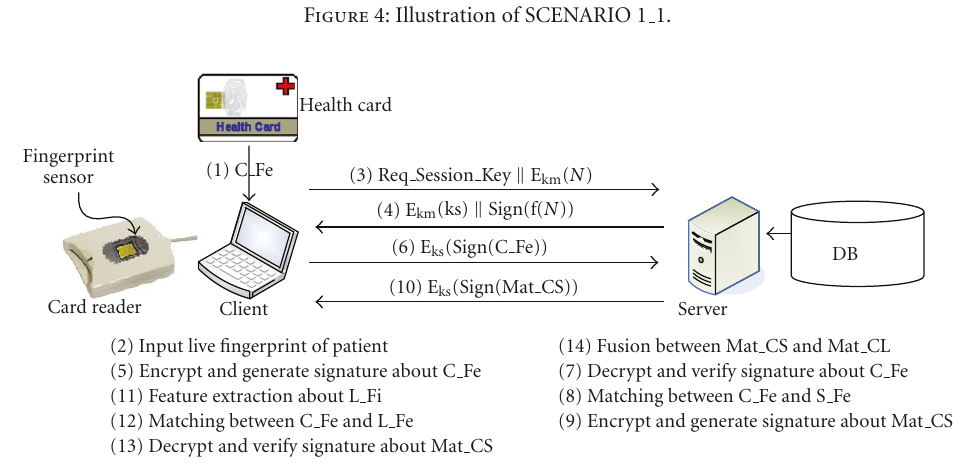
Figure 4: Illustration of SCENARIO 1 1.